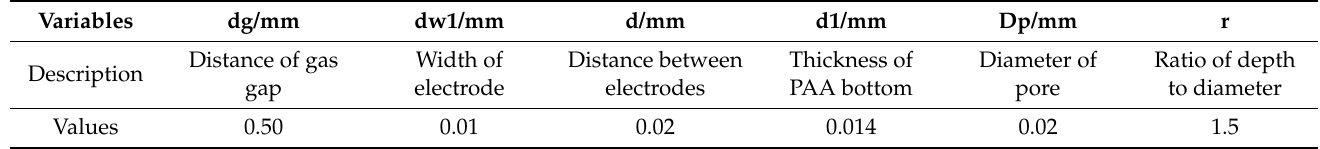
Figure 9. Discharge circuit dielectric barrier discharge. Table 1. Parameters of the geometry of the porous anodic alumina in a CPED device.